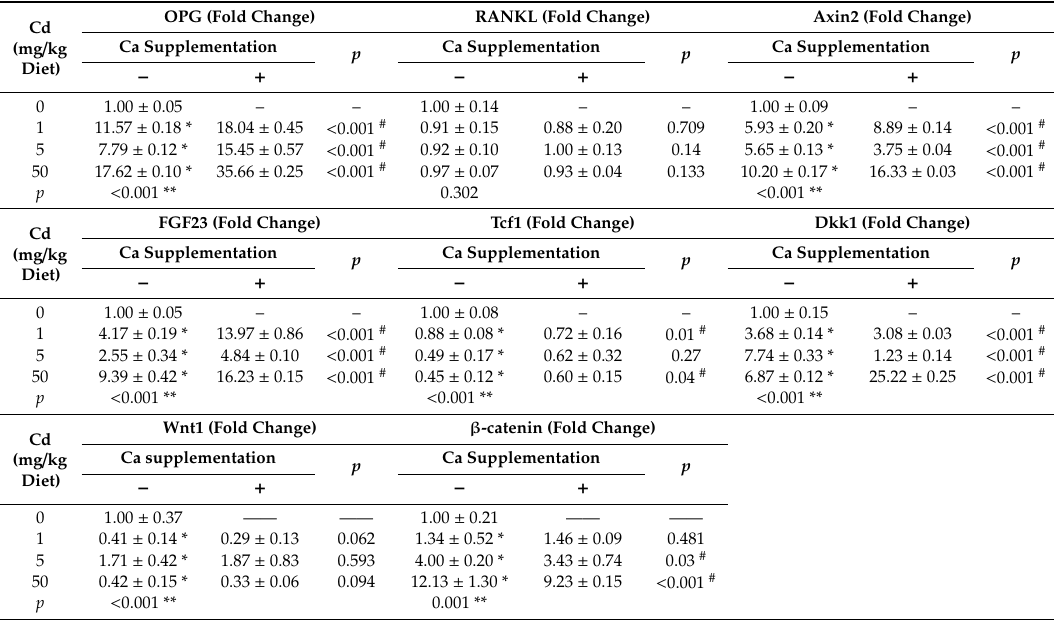
Table 14. Expression changes of FGF23 / Klotho-associated gene using quantitative real-time polymerase chain reaction in the femurs in the study of moderate Ca supplementation exposure to di ff erent diet Cd (Exp 2).